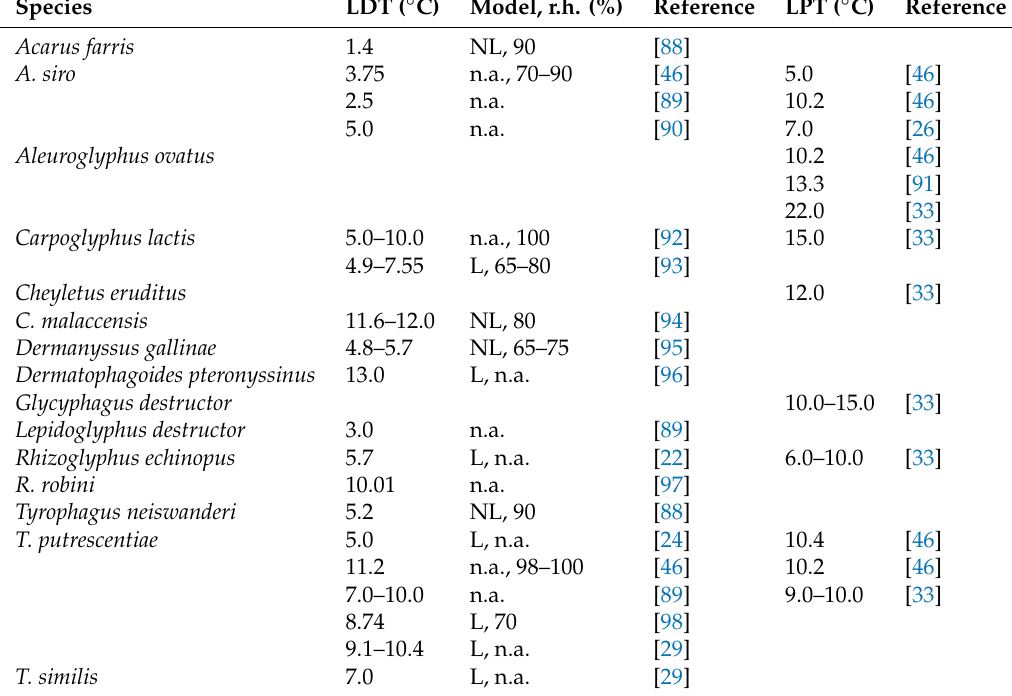
Table 1. Threshold temperatures for the individual (LDT) and population (LPT) development of selected stored product mites. L—estimated based on linear model, NL—estimated based on non-linear model, n.a.—data are not